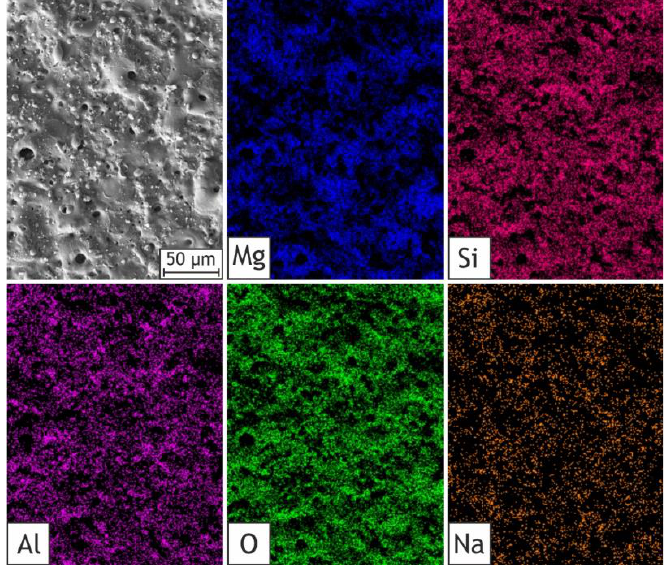
Figure 7. SEM image and EDS maps of elements distribution for the H40 sample: Mg, Si, Al, O, Na.